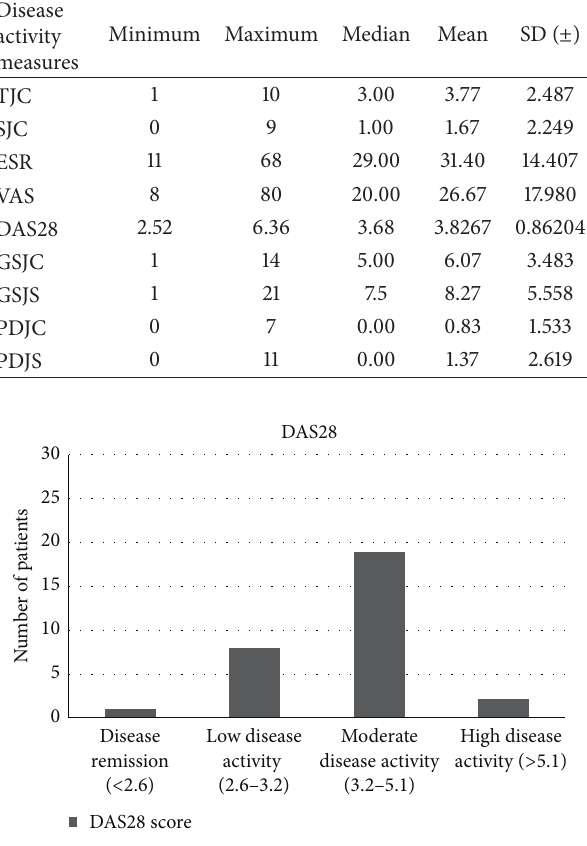
Figure 2: Distribution of patients in DAS28 subcategories.